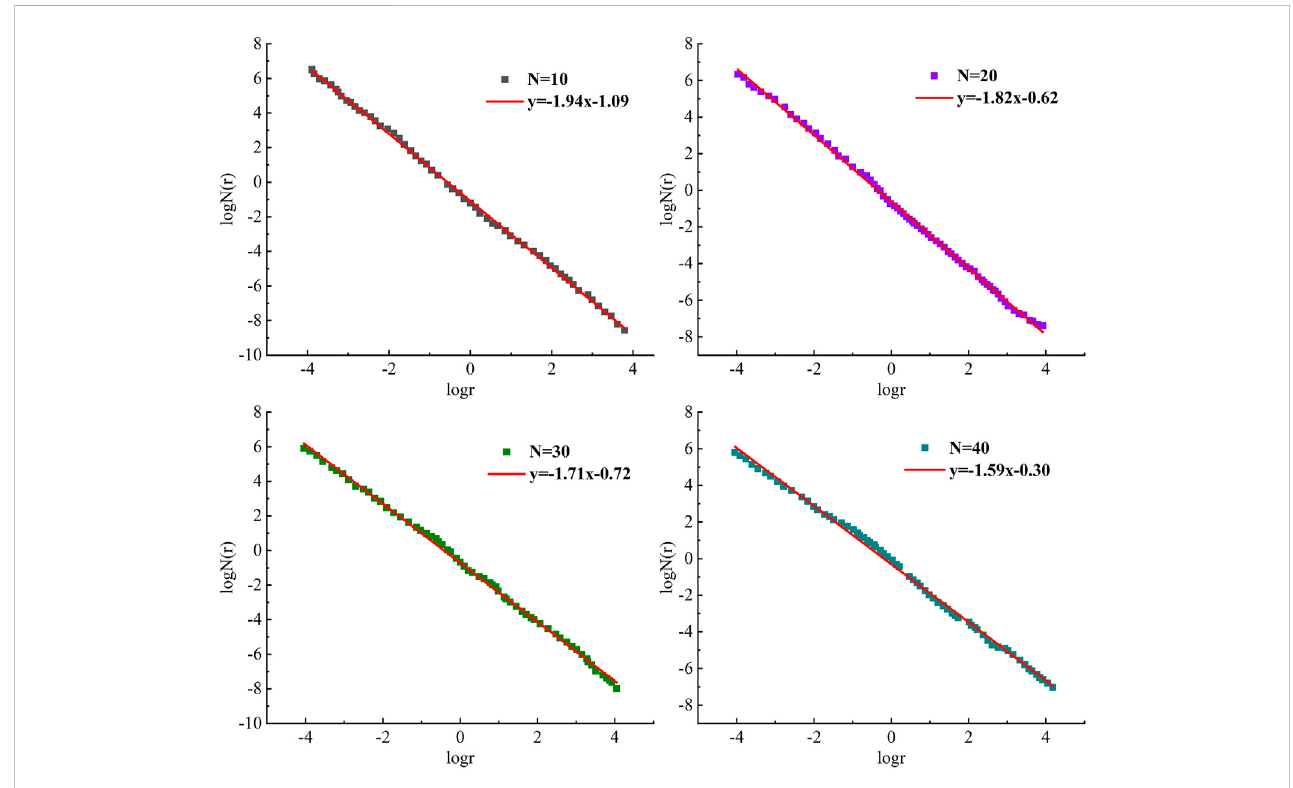
FIGURE 8 Fractal dimension of sandstone with different freeze-thaw